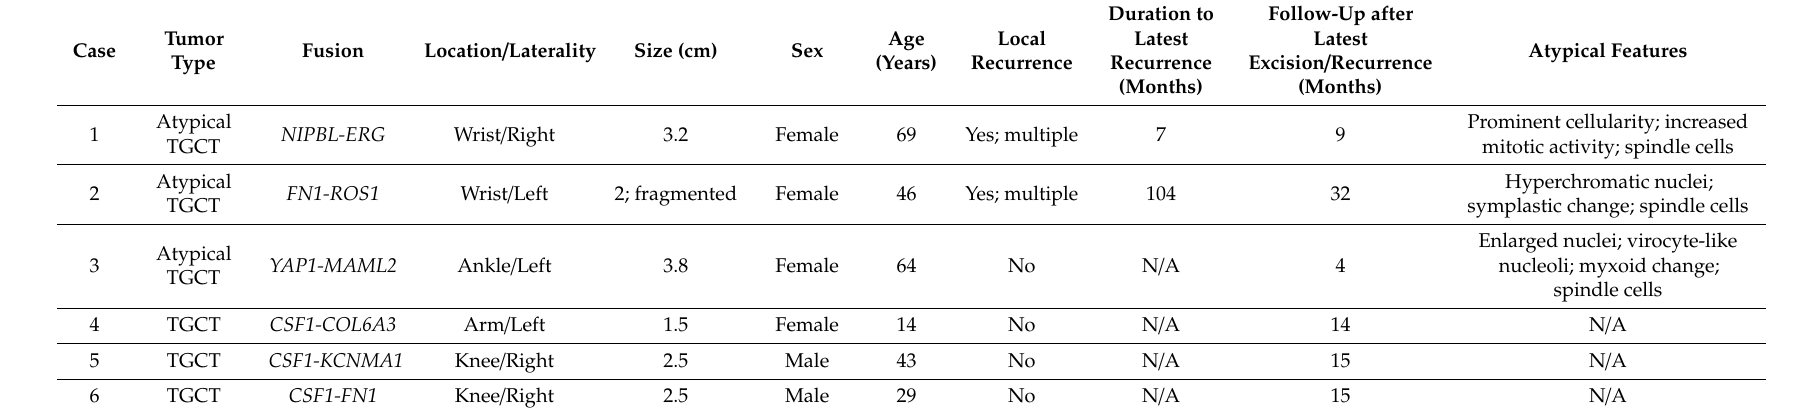
Table 1. Summary of clinical features and molecular findings. N / A, not